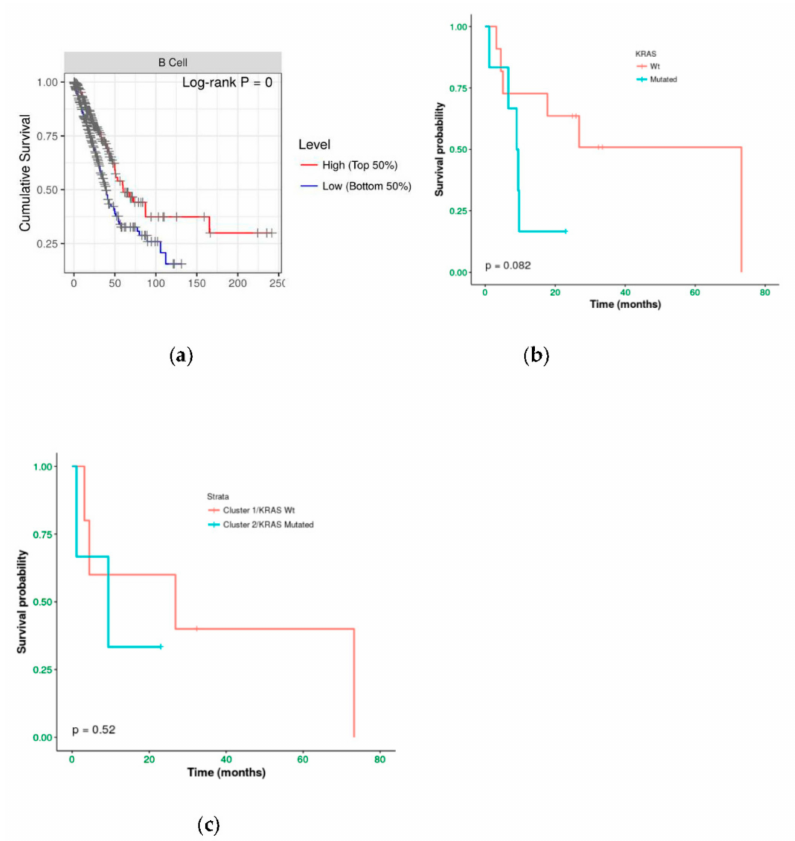
Figure 6. Kaplan–Meier curves of ( a ) TCGA-LUAD cohort stratifying for B cell infiltration and real-life cohort stratified for ( b ) KRAS mutational status and ( c ) cluster